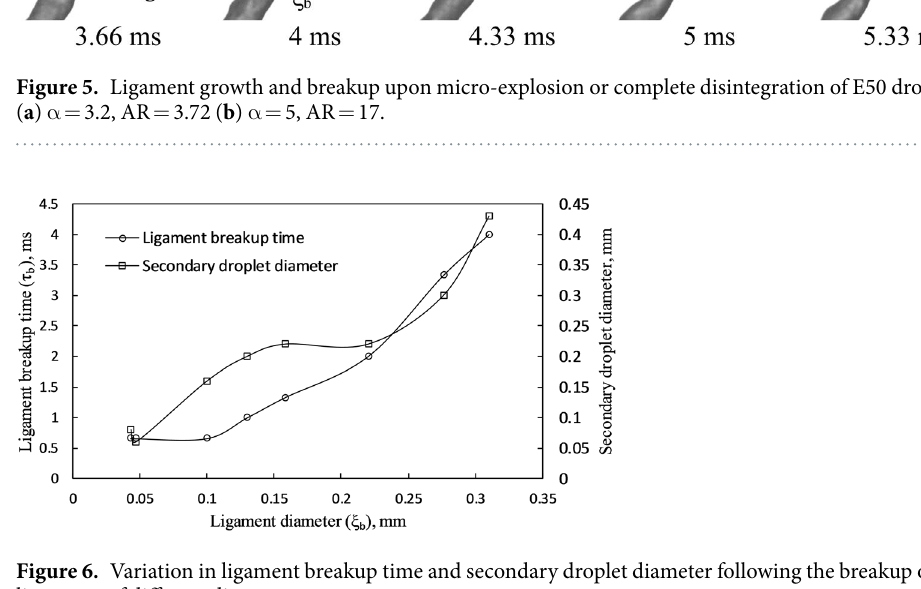
Figure 6. Variation in ligament breakup time and secondary droplet diameter following the breakup of ligaments of different